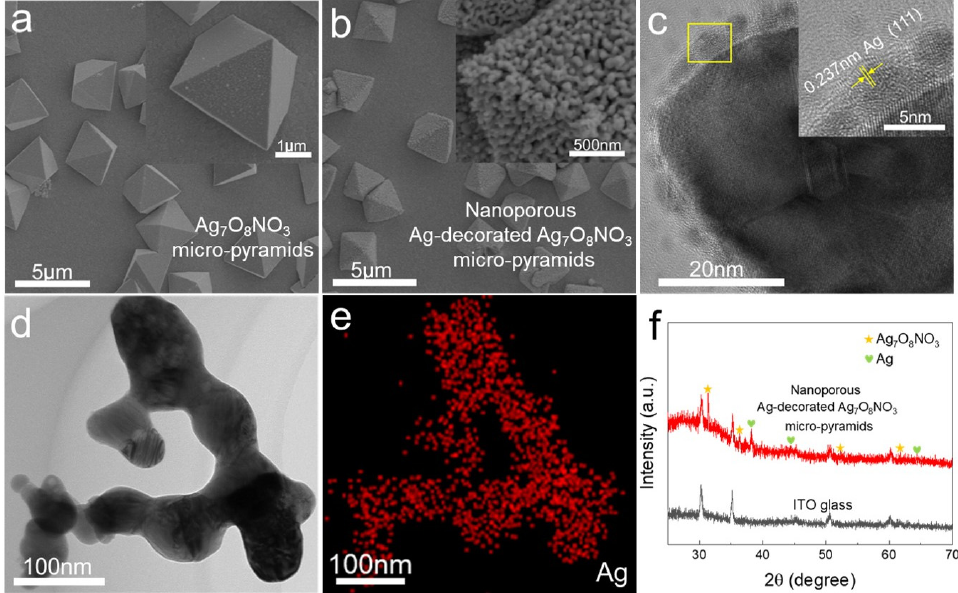
Figure 1. ( a ) SEM image of the Ag 7 O 8 NO 3 micro-pyramids fabricated by electrodeposition at 3 V for 300 s. The inset is a magnified image. ( b ) SEM image of the nanoporous Ag-decorated Ag 7 O 8 NO 3 micro-pyramids prepared by reducing the surface of Ag 7 O 8 NO 3 in a NaBH 4 solution. The inset is a magnified image. ( c ) TEM image of nanoporous Ag, and the inset is the corresponding high-resolution transmission electron microscopy (HRTEM) image marked in the yellow box in ( c ). ( d ) TEM image of Ag nanostructure peeled off from a nanoporous Ag-decorated Ag 7 O 8 NO 3 micro-pyramid through ultrasonic. ( e ) Corresponding elemental mapping of Ag collected form the area shown in ( d ). ( f ) XRD patterns of (upper curve) the prepared nanoporous Ag-decorated Ag 7 O 8 NO 3 micro-pyramids and (lower curve) an ITO glass.